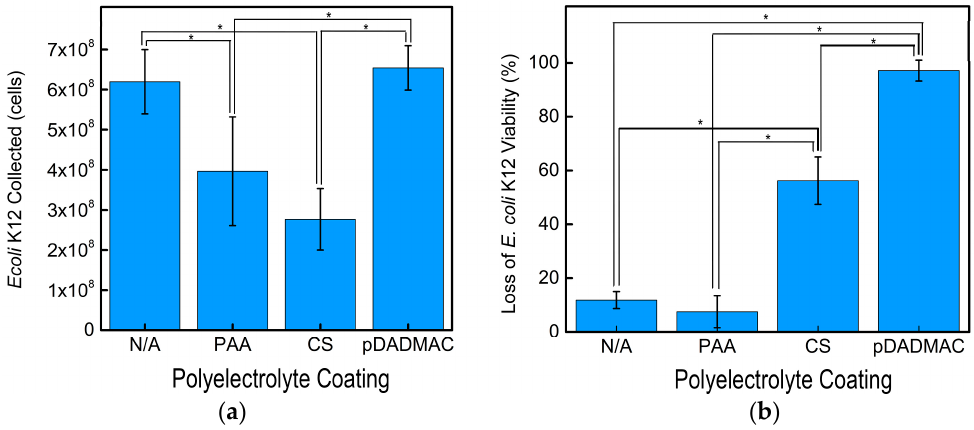
Figure 5. ( a ) The average number of E. coli K12 collected after 120 min using cellulose nanofiber mats without functionalization (N/A) and functionalized with PAA, CS, and pDADMAC; ( b ) The average loss of viability for E. coli K12 after 180 min using cellulose nanofiber mats without functionalization (N/A) and functionalized with PAA, CS, and pDADMAC. Collection and viability data reported for N = 3 samples. Error bars represent standard deviation and the statistical significance determined using an unpaired t-test between samples is shown by an *.